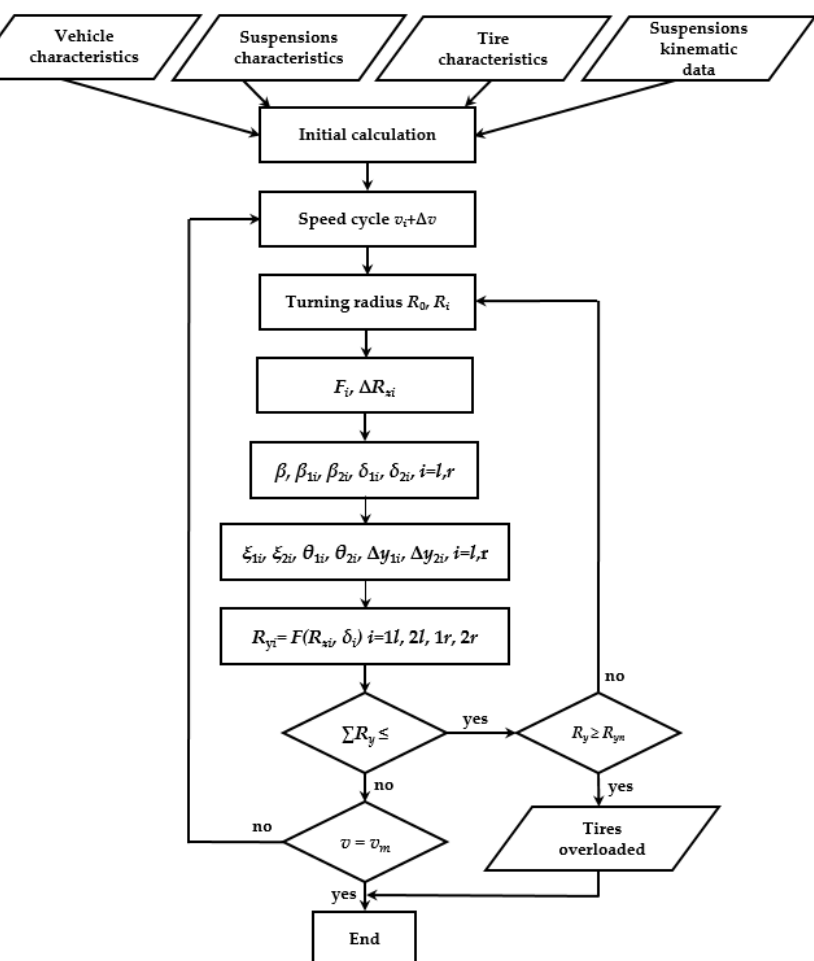
Figure 28. Vehicle boundary turning radius calculation program AUTOSTAB algorithm.